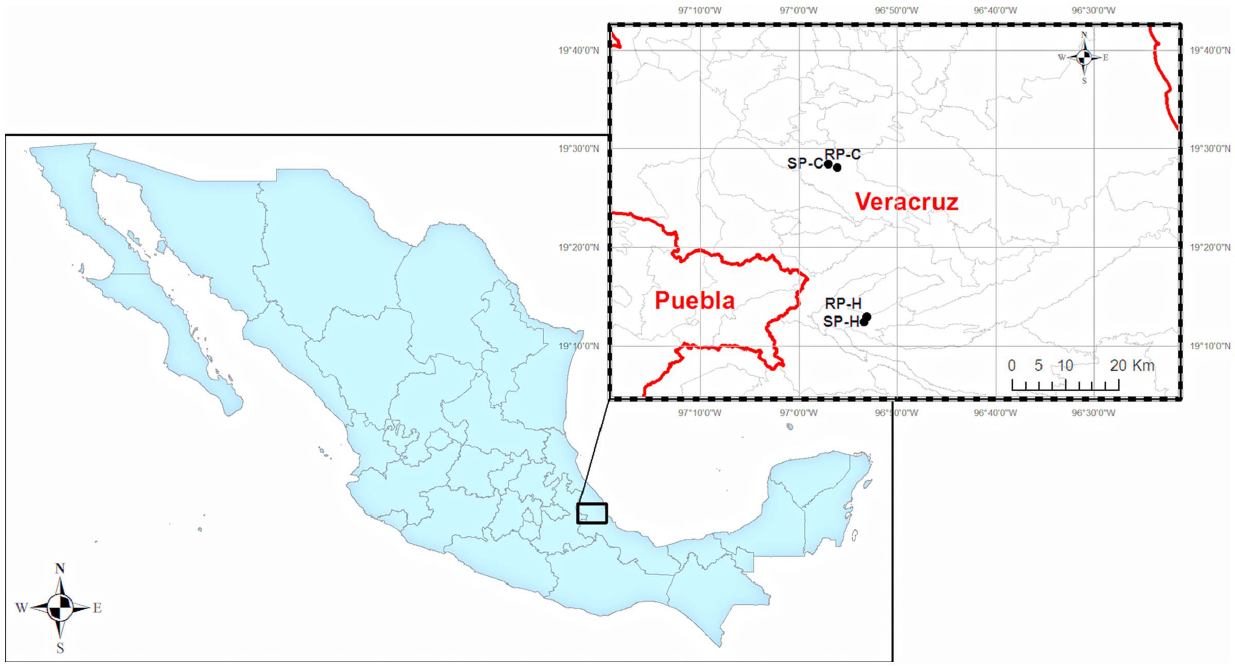
Figure 1. Map of survey area: geographical locations of the four coffee plantations, Veracruz, Mexico. RP-C: rustic plantation Coatepec, SP-C: simple polyculture Coatepec. RP-H: rustic plantation Huatusco, SP-H: simple polyculture Huatusco.